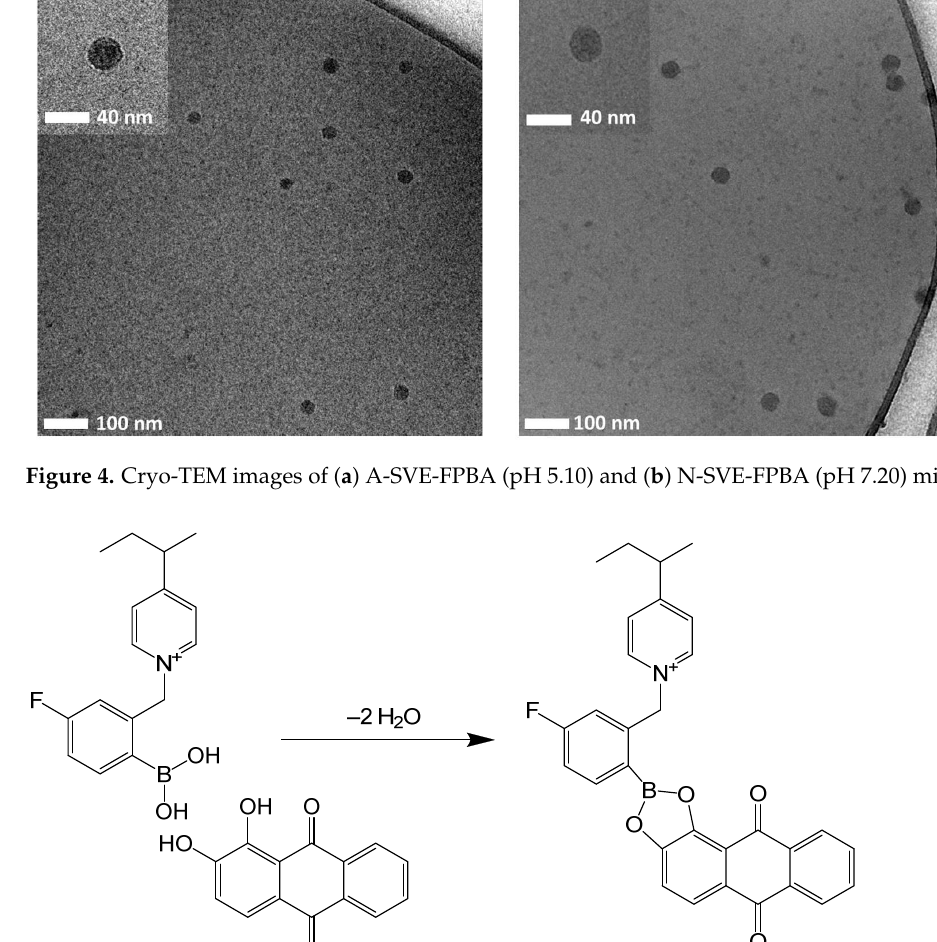
SVE-FPBA micelles using UV-Vis absorption spectroscopy.